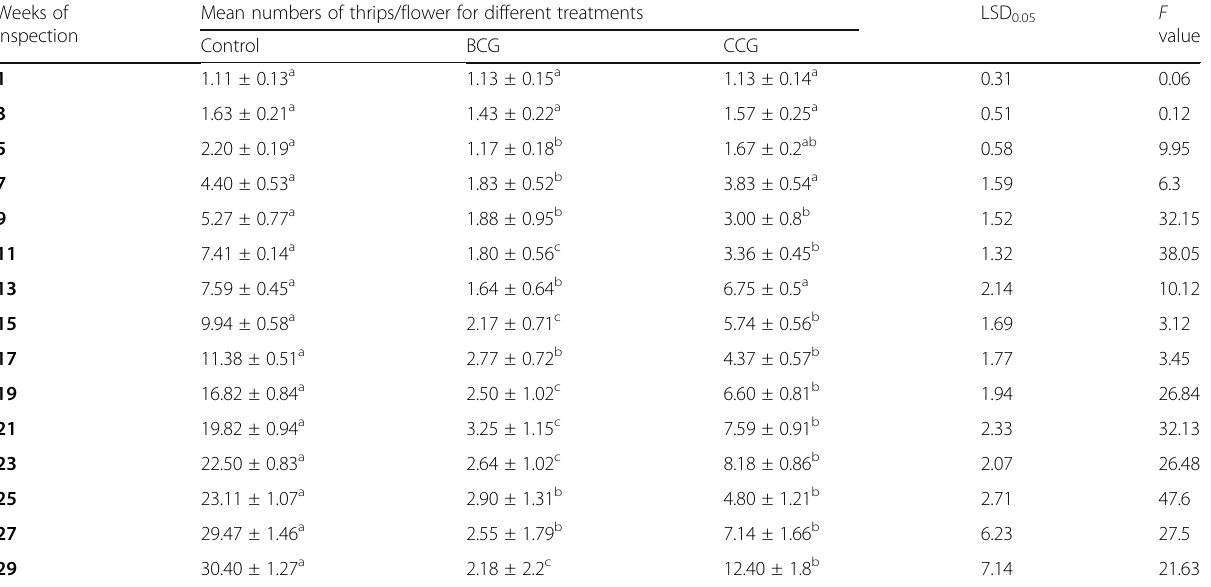
Means followed by the same letter at the same row are not significantly different ( p ≤